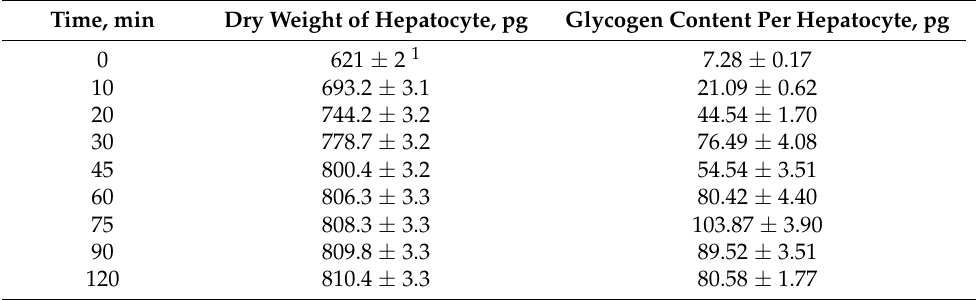
Table 1. Average dry weight of hepatocyte and absolute glycogen content in them at different time intervals after glucose administration to fasting rats.